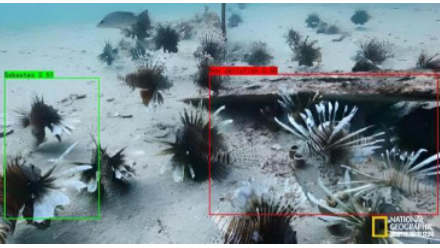
Fig. 8. Detection results of the YOLOX model after super-resolution processing with ESRGAN.